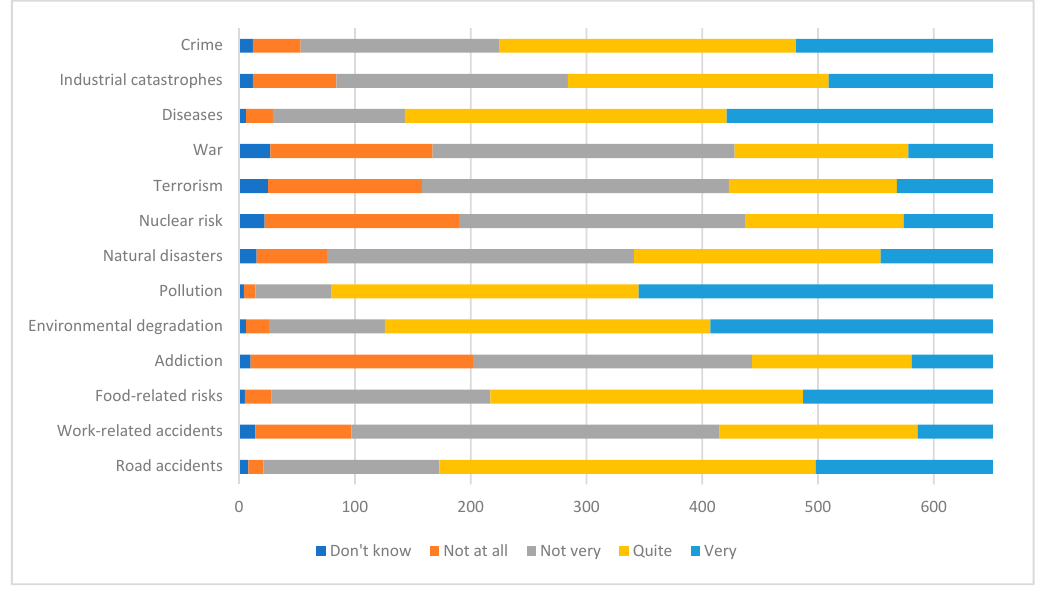
Figure 4. Health-threatening events declared by respondents.